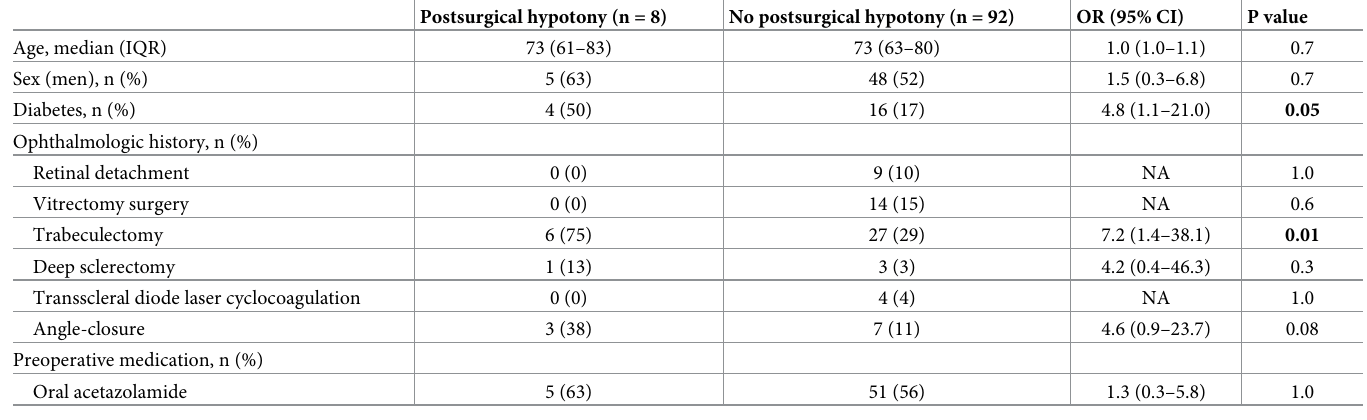
Table 4. Risk factors for developing postsurgical hypotony.